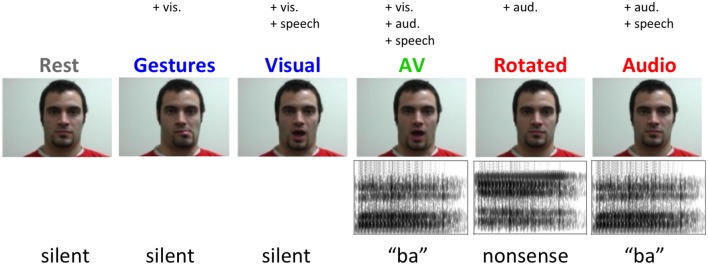
Example stimuli from each experimental condition.